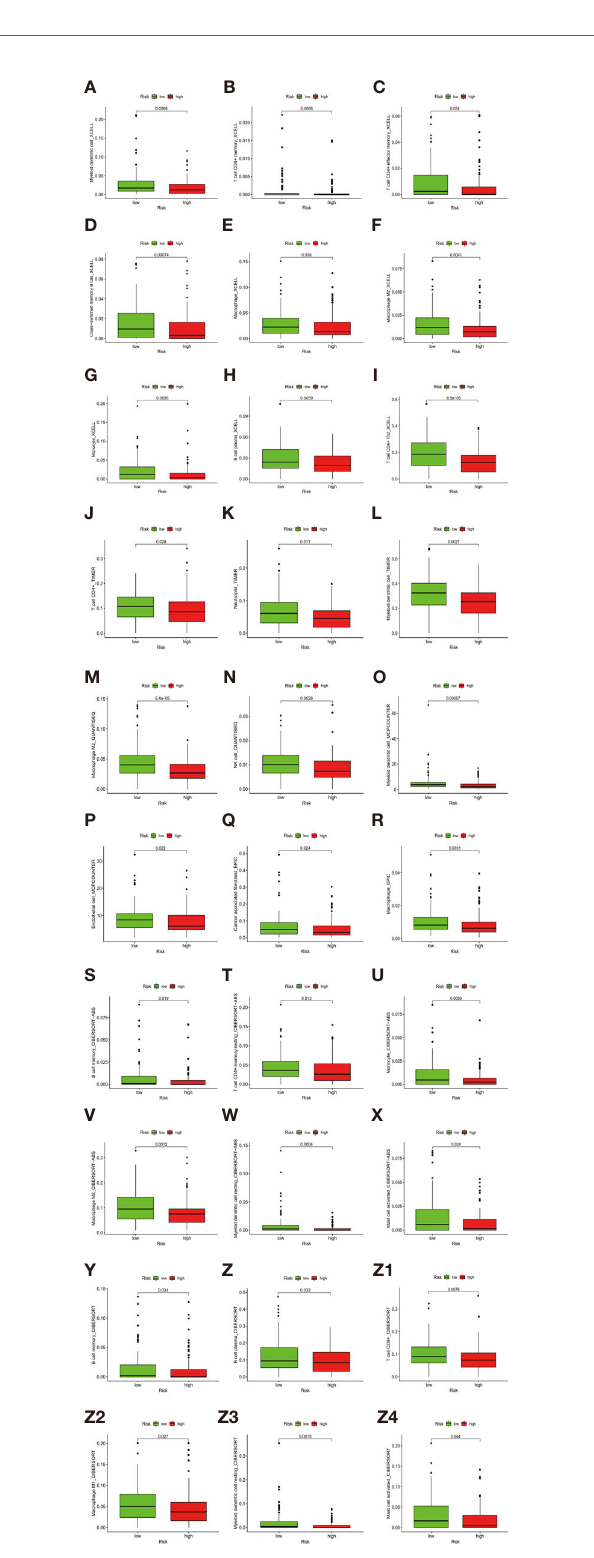
FIGURE 8 | (A – Z4) The Wilcoxon signed-rank test revealed the lower levels of extensive immune in fi ltration cells such as T cell CD4+ central memory, T cell CD4+ Th2, T cell CD8+, T cell CD8+ naive, myeloid dendritic cell, and macrophage.